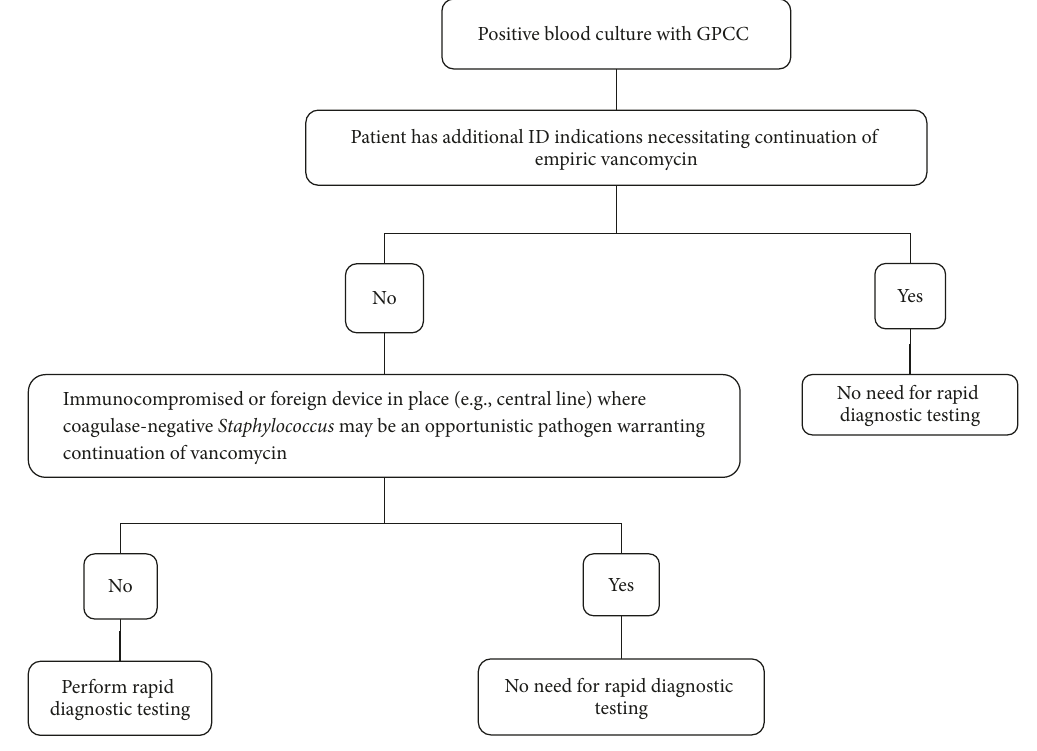
Figure 1: Criteria for rapid diagnostic testing a